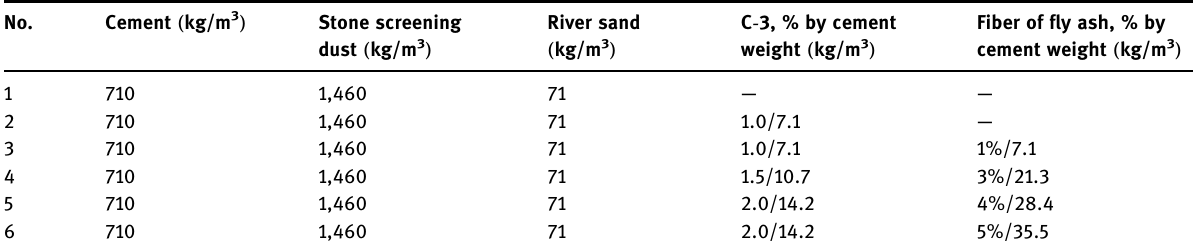
Table 9: Compositions of FGC with the addition of fi ber of fl y ash